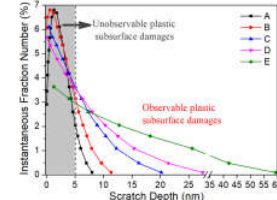
Fig. 2. The calculated bear load of different particles in different polishing processes.